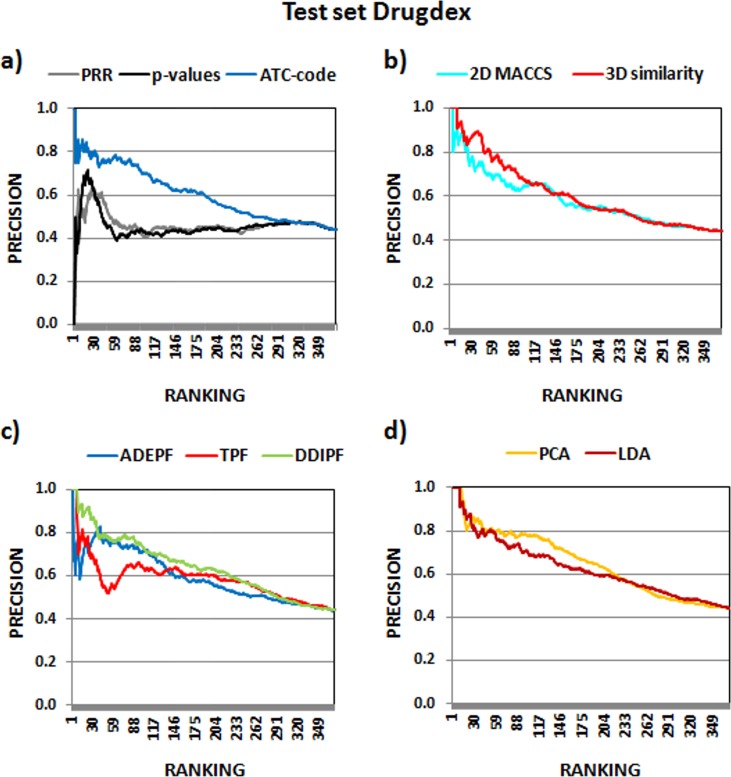
Precision of the different methods in test set 1 with all the interactions described in the reference standard Drugdex (interactions well_established+probable+theoretical).